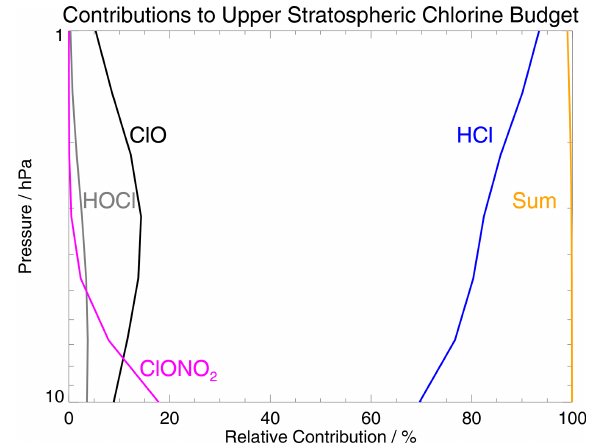
Figure 12. Percent contributions of various species (daytime HCl, ClO, HOCl, and ClONO 2 ) to the upper stratospheric chlorine bud- get between 10 and 1hPa, based on climatological (16 years) day- time model results in the 50 ◦ S to 50 ◦ N latitude range. The sum of these contributions is shown in orange; there are also very small contributions in this pressure range from other species (Cl, Cl 2 , Cl 2 O 2 , OClO, BrCl, which are not represented here).